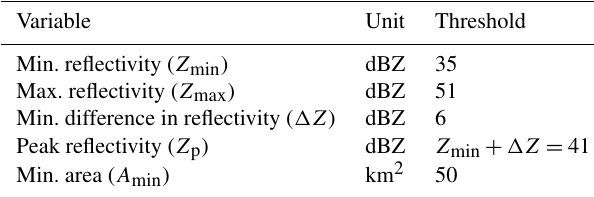
Table A1. Thunderstorm detection